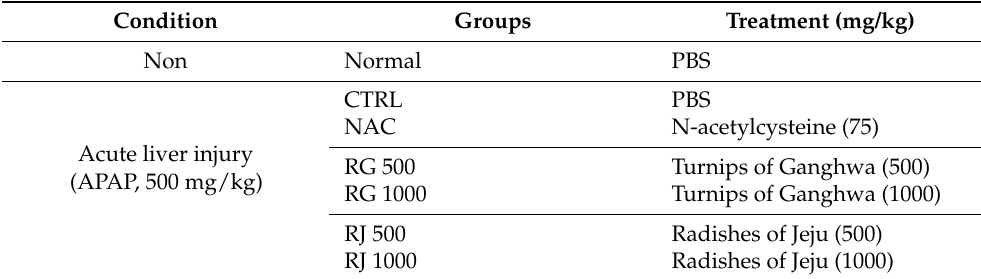
Table 1. Animal experimental groups and